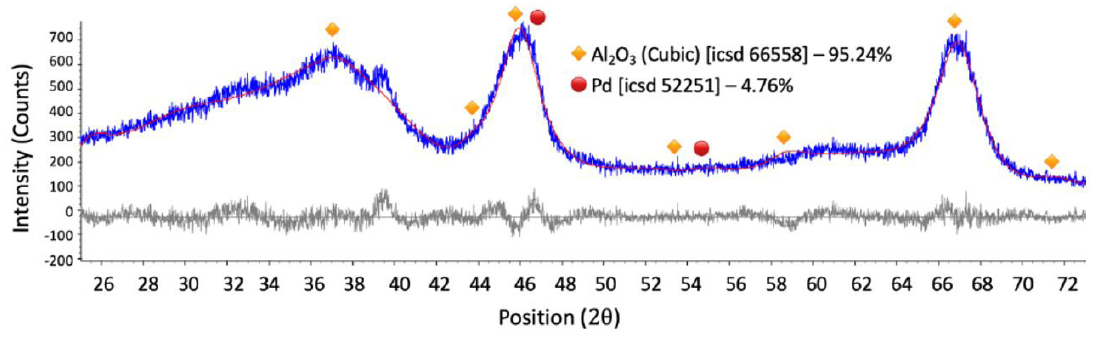
Figure 5. XRD pattern of the Pd/Al